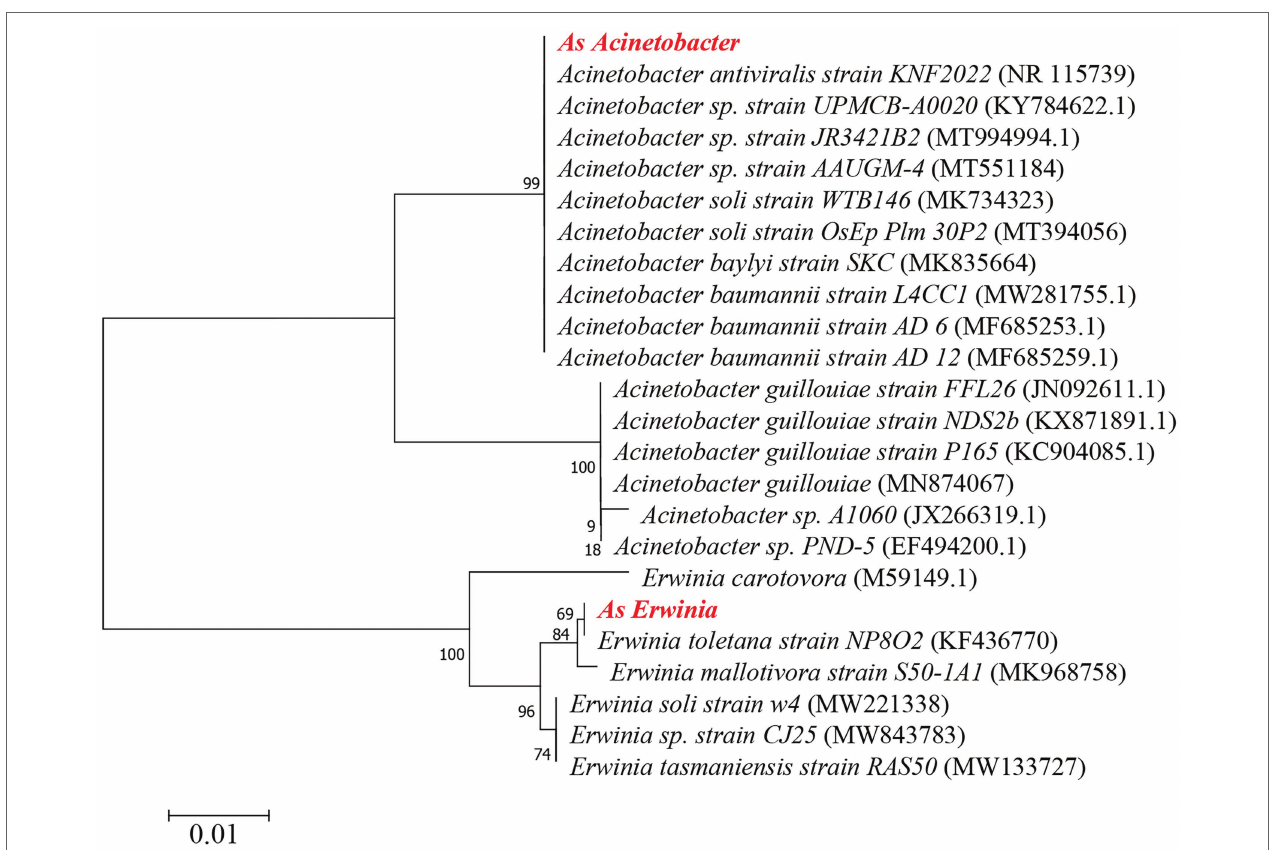
FIGURE 4 | Phylogenetic analysis of Erwinia and Acinetobacter . As Erwinia : A. suturalis Erwinia , As Acinetobacter : A. suturalis Acinetobacter . The phylogenetic tree was made by MEGA7.0 software and constructed by the Neighbor-joining method. The number in parentheses indicates the GeneBank accession number of the 16S rRNA gene